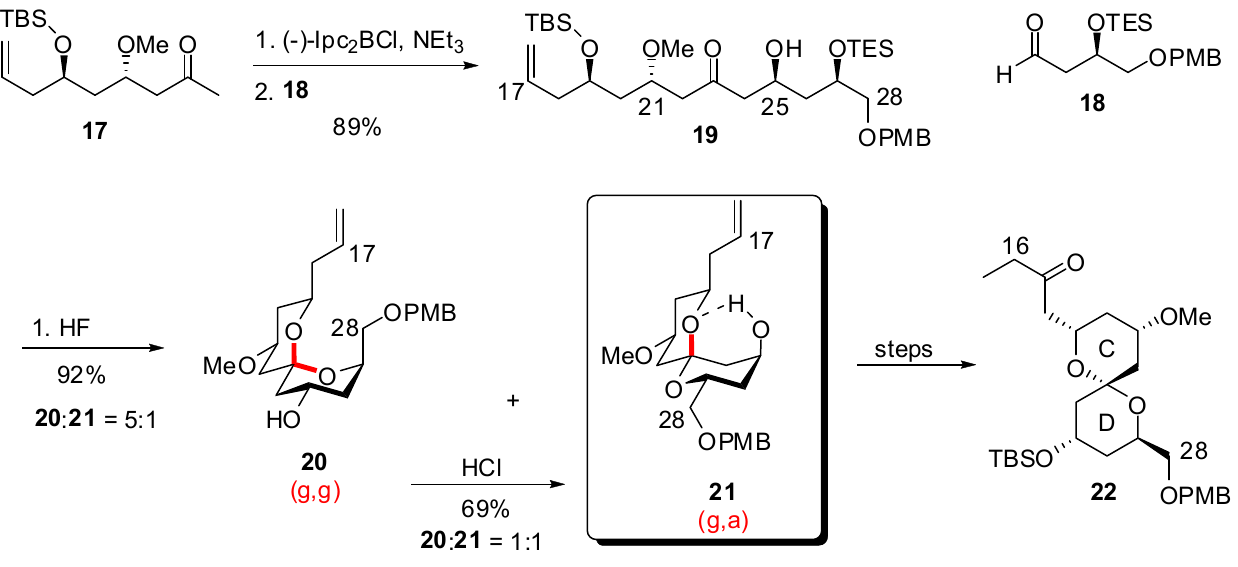
Scheme 3. Synthesis of the CD spiroketal of spongistatin 1 under thermodynamic control according to Paterson et al